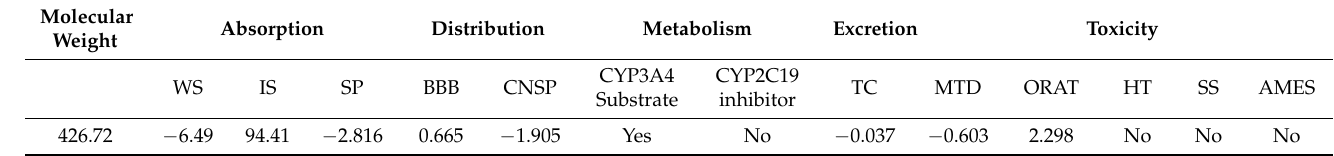
Table 1. ADMET analysis of glutinol.